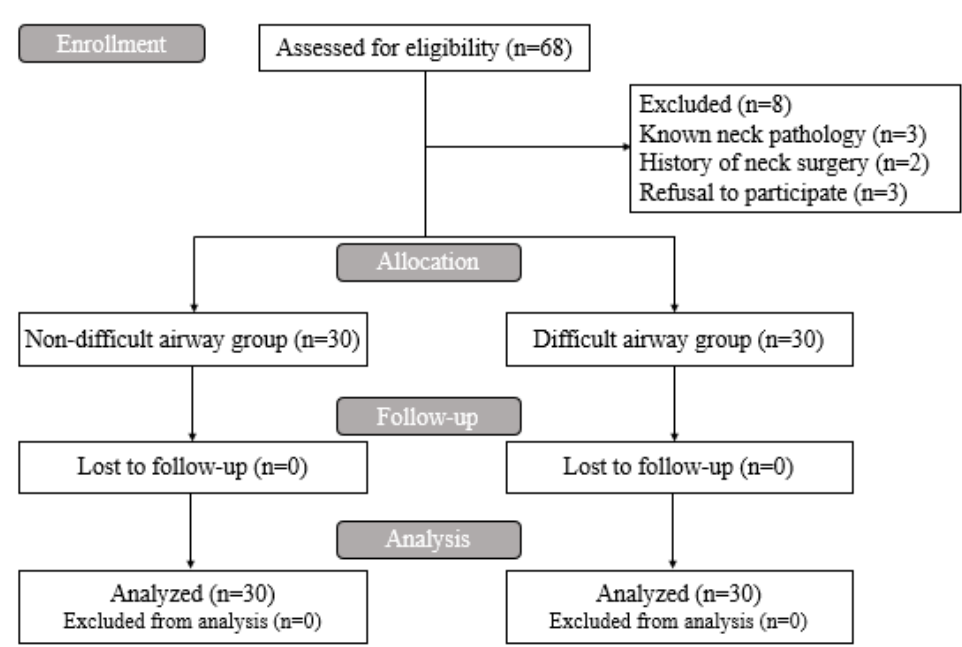
Figure 1. CONSORT flowchart of this clinical study.